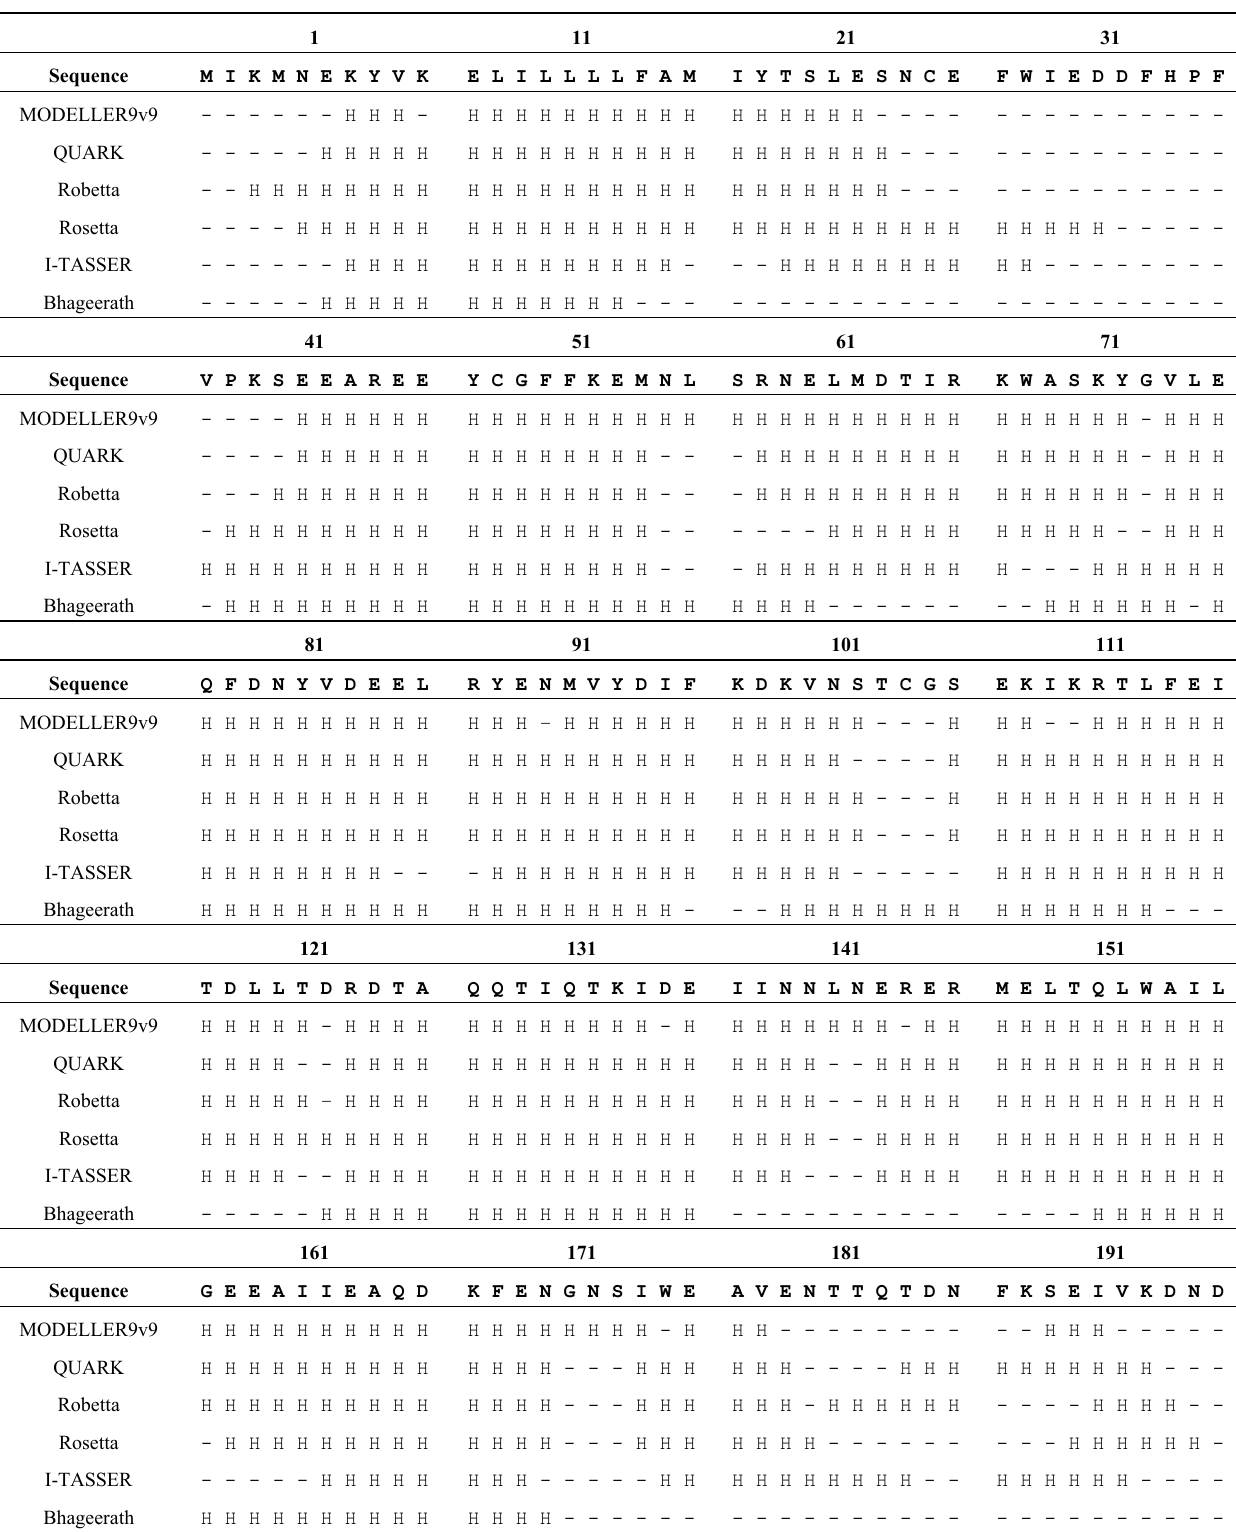
Table 2. Secondary structure calculation by STRIDE [9] on the models built by MODELLER 9v9 [10], QUARK [11], Robetta [12,13], Rosetta [14], I-TASSER [15] and Bhageerath